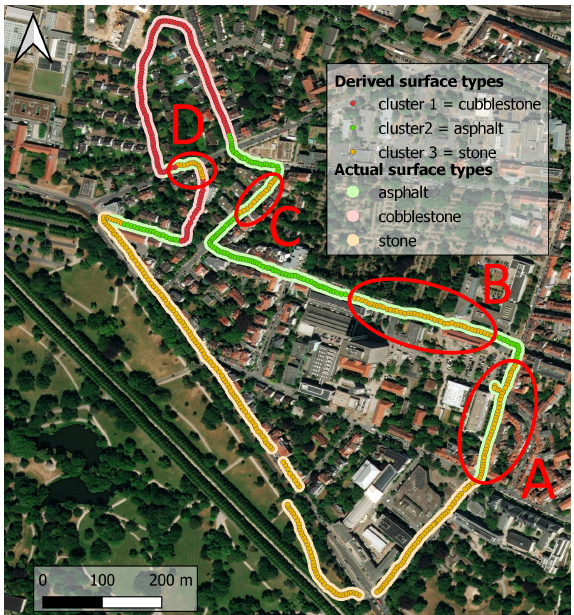
Figure 7. Comparison of the derived homogeneous trajectory segments (colored dots) to the actual surface types (colored background). Source of basemap: ESRI